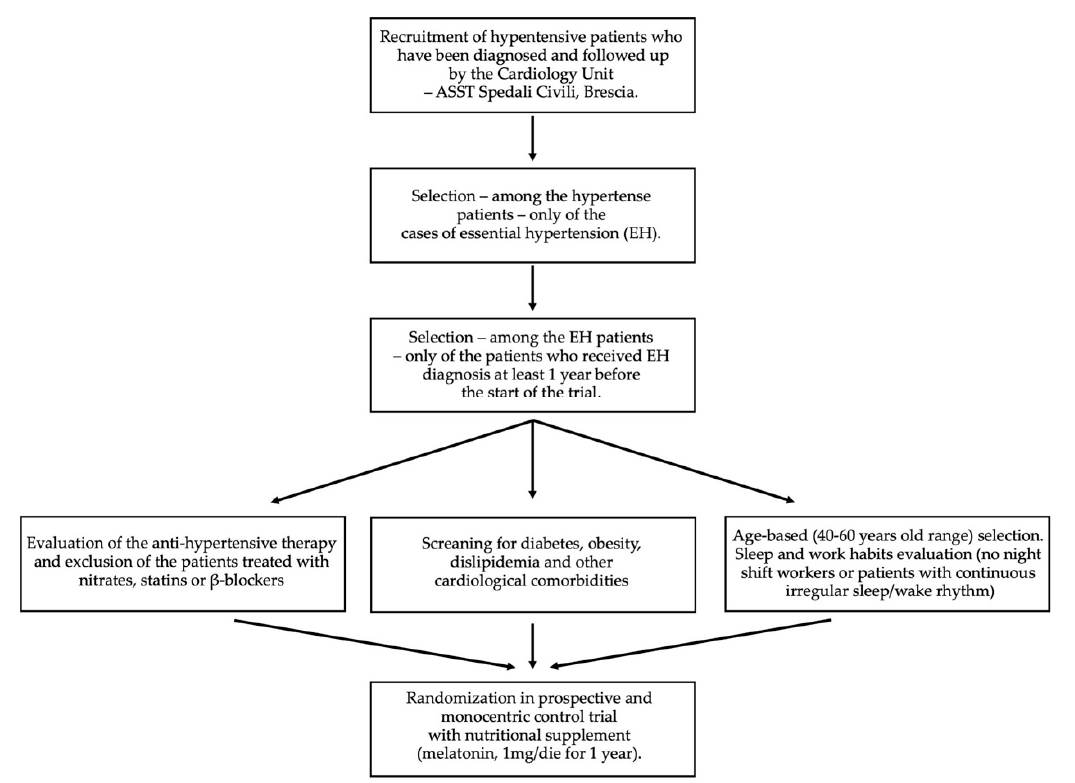
Figure 3. Schematic representation of the study design.